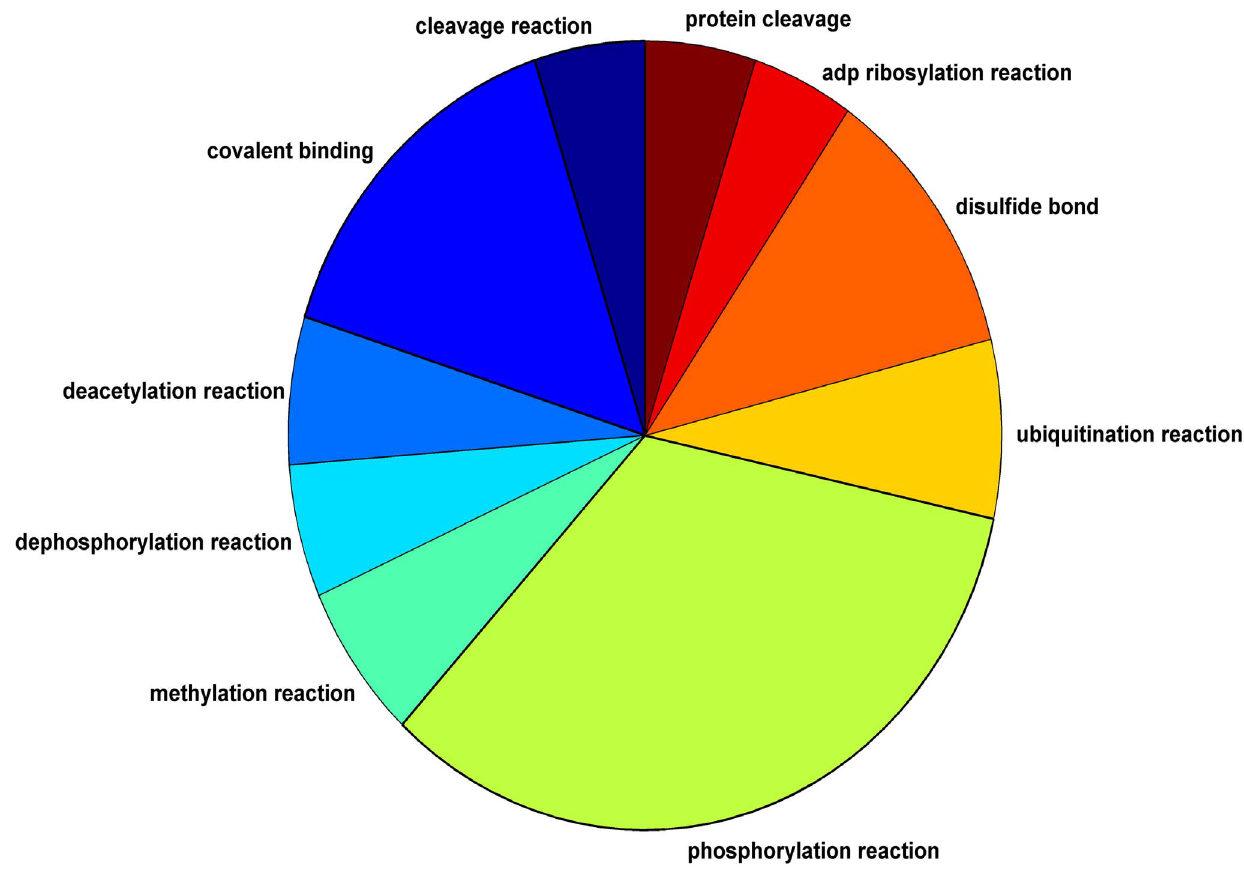
Figure 2. distribution of predicted interaction types.